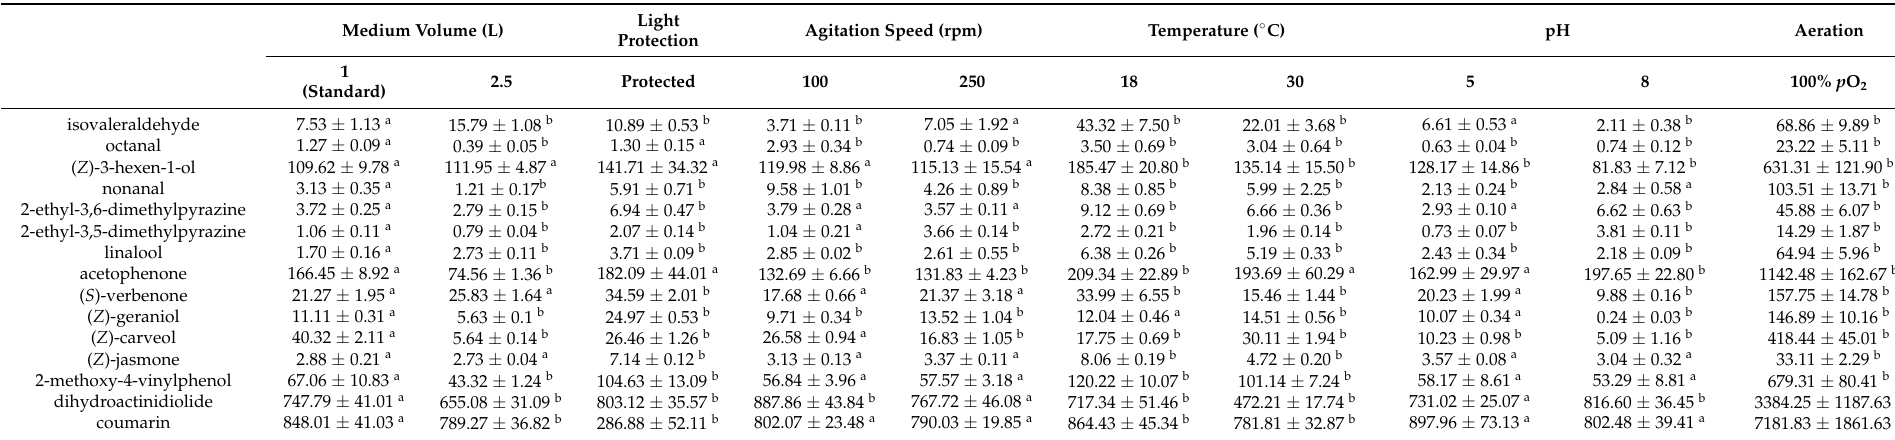
Table 3. Concentrations of key aroma compounds detected in the fermented broth produced in different bioreactor